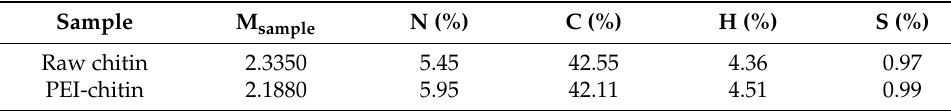
Figure 1. SEM images of ( a , b ) raw chitin and ( c , d ) PEI-chitin ( a , c : × 500 magnification, and b , d : × 5000 magnification). Table 1. Elemental analysis results of raw chitin and